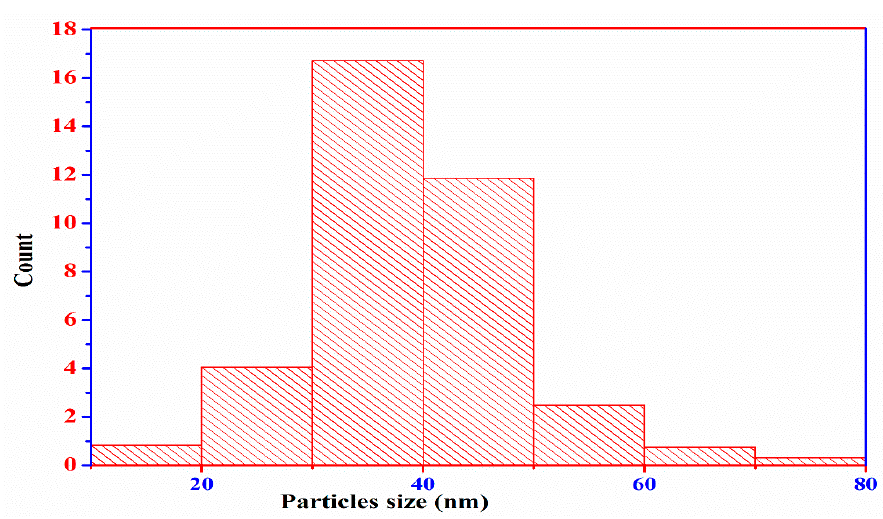
Figure 7. Histogram spectrum of CuONPs.